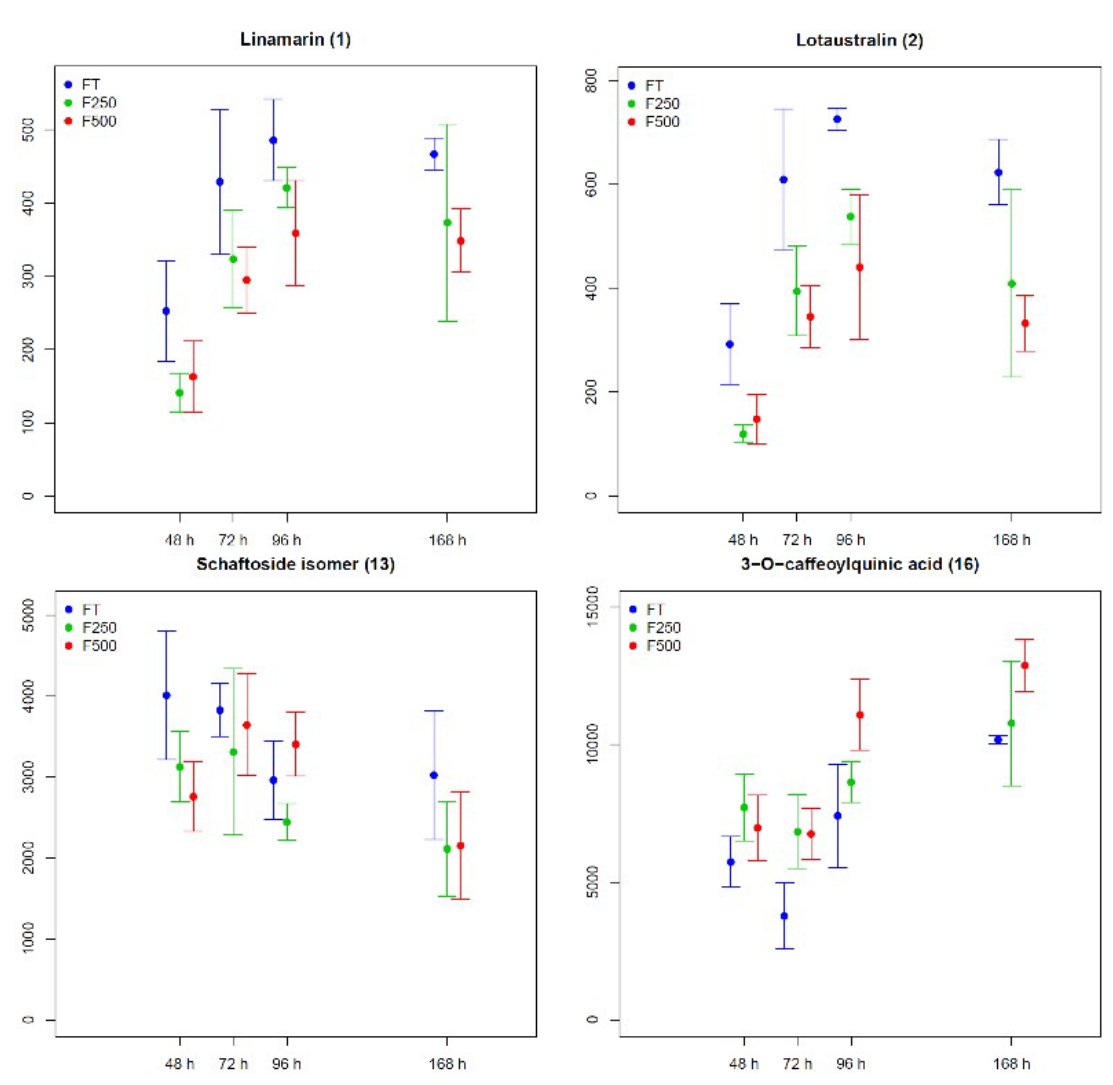
Figure A1. Comparison of some discriminating metabolite content in flax shoots from control (FT) and seedling treated with COS oligosaccharides solutions (F250 and F500).